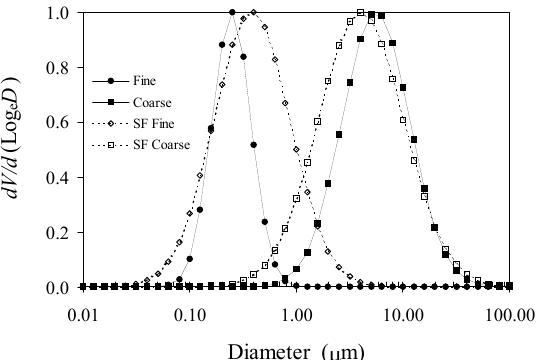
Figure 9. Volume size distributions, d V / d (cid:96) nR in units of µ m 3 / µ m 2 , for a pure maritime regime. ( Left panel ) Average of measurements at three remote locations. ( Right panel ) Comparison between the measurements at the Lanai location and the analytic fit to the sum of two log-normal volume distributions. Volume Size Distributions